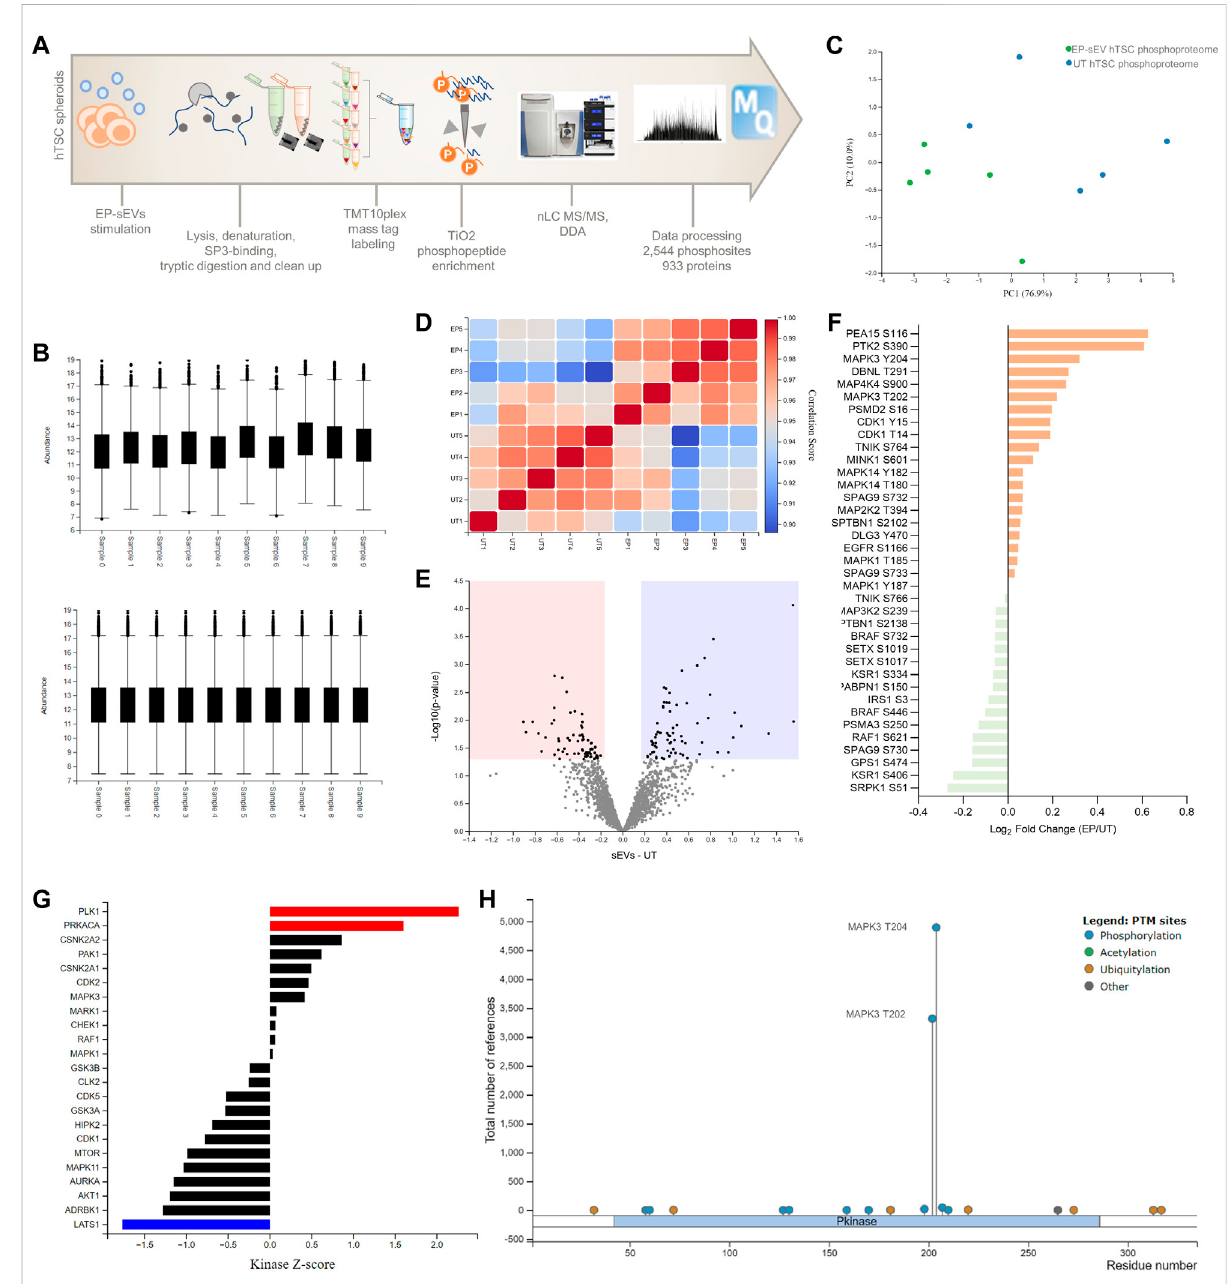
FIGURE 3 Phosphoproteomic analysis reveal endometrial small extracellular vesicles activate MAPK3 signaling in hTSCs. (A) Experimental design of phosphoproteome analysis of hTSCs in response to EP-sEVs. (B) Relative abundance of the quanti fi ed phosphoproteome before and after z-score normalization[phosphomatics(Leeming etal.,2021)].Boxescapturelowerquartile andupperquartilewithmediandisplayed;whiskersmin/max. (C) Principalcomponentanalysisofthephosphoproteome. (D) Correlationmatrixofthephosphoproteome. (E) Volcanoplotshowingdifferentially regulatedphosphoproteomeinhTSCswithEP-sEVtreatment.Signi fi cantlyregulatedphosphosites(byt-testfromPerseus)wereindicated(adjusted p < .05 and fold change log > 0.6). (F) Log fi c kinase phosphosites differentially regulated in response to EP-sEV treatment. (G) 2 2 (intensity) of speci Upstreamkinasesand/orphosphatasesfromphosphoproteomepro fi lesinresponsetoEP-sEVtreatmentwereanalysed. (H) PhosphoSitePlusreport on the number of studies for MAPK3 T202 and T204